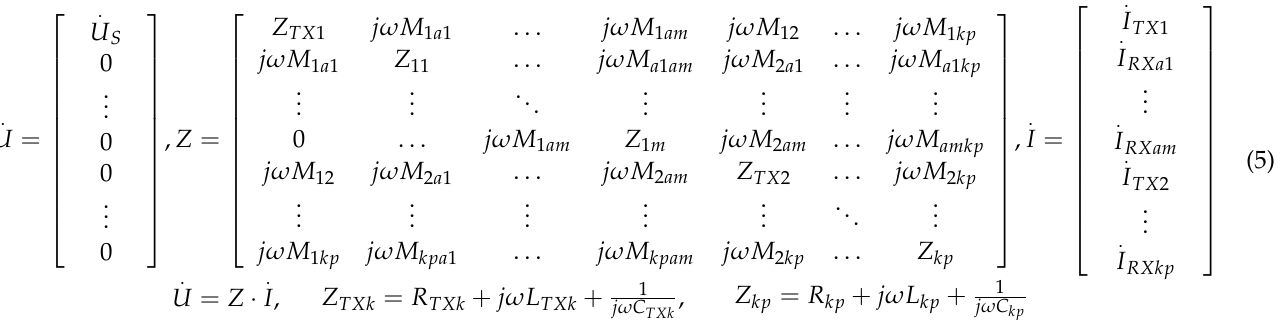
Figure 5. The equivalent circuit of the proposed WPT system. The Kirchhoff Voltage Laws (KVL) equations for the first layer of the transmitter coil, for each layer of the relay transmitter coil, and for the receiver coils are listed, respectively, as follows: